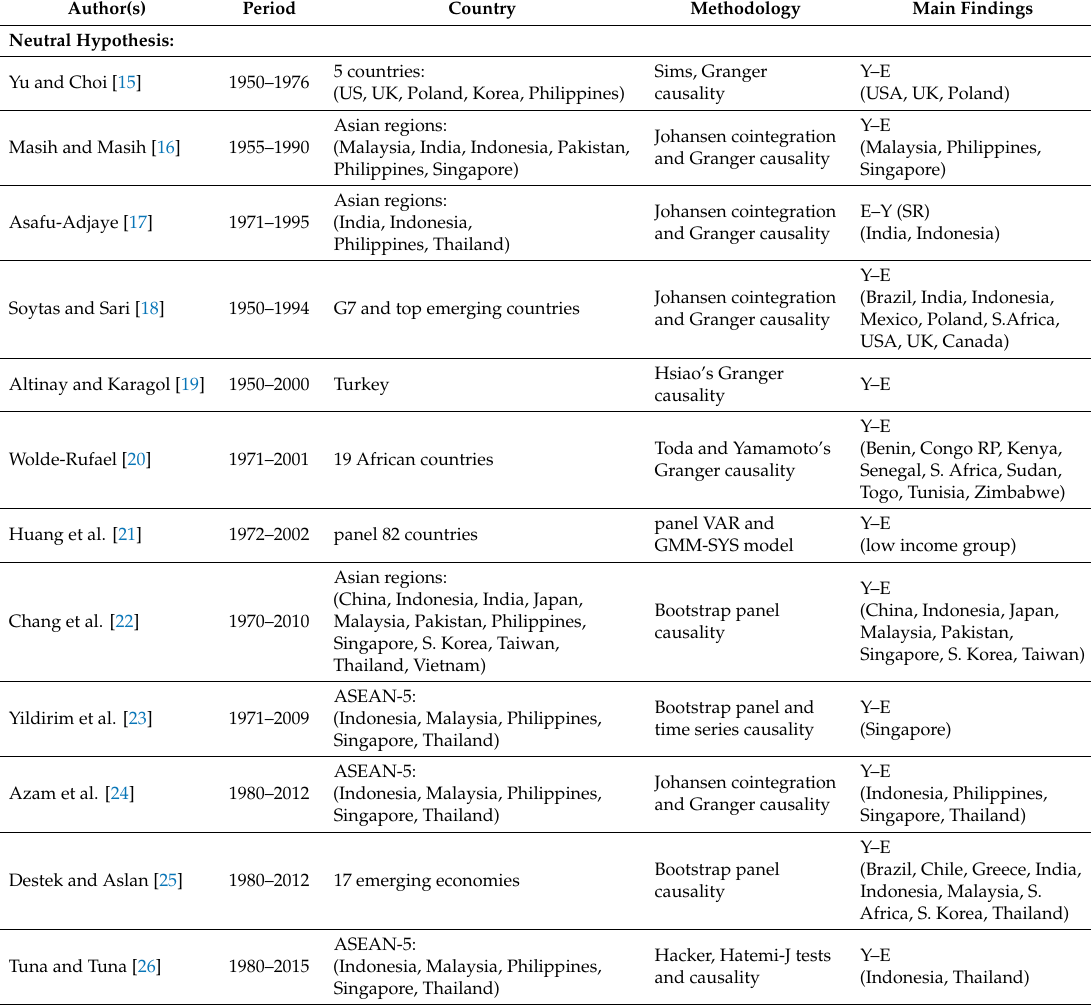
Table A1. Literature on “Energy–Growth” Causality